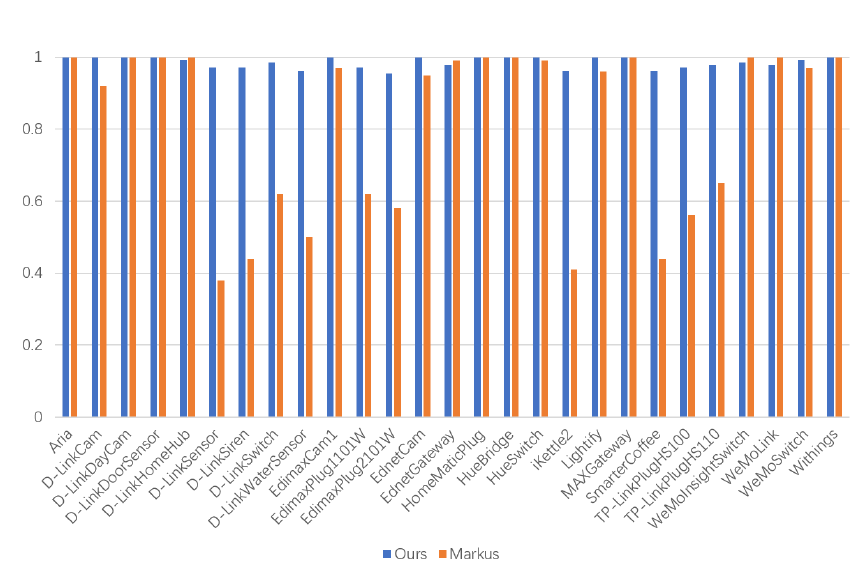
Figure 6. Method